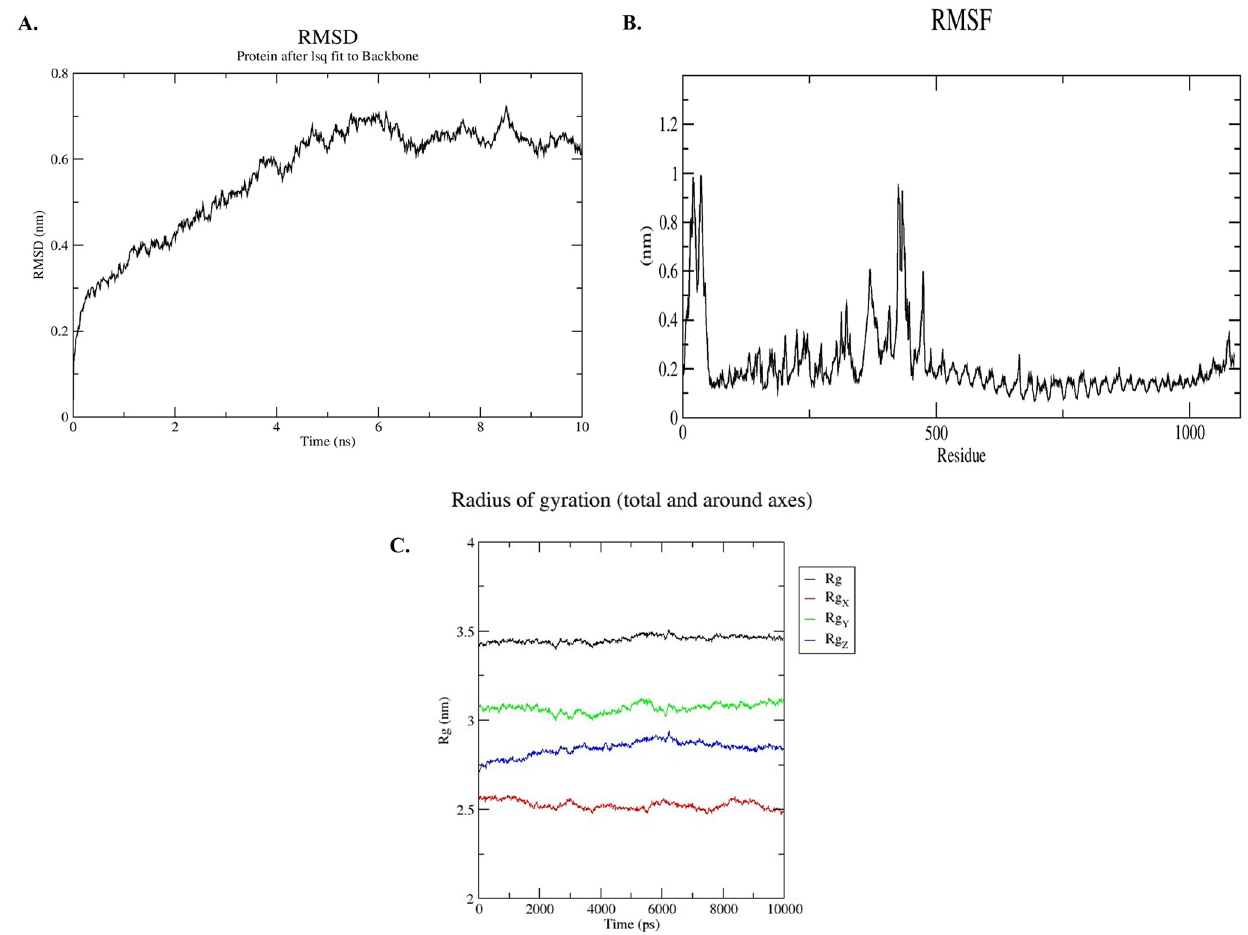
Fig 8. Molecular dynamics simulation of the vaccine protein with human toll like receptor-4. (A) RMSD-Root Mean Square Deviation of docked complex shows very minor deviation reflecting the stable interaction between vaccine protein and TLR-4 molecule. (B) RMSF-Root Mean Square Fluctuation plot of docked protein complex remained fairly flat reflecting the flexibility of side chain of docked protein complex. (C) Rg plot of docked complex shows a relatively flat curve suggesting stable vaccine-receptor complex.